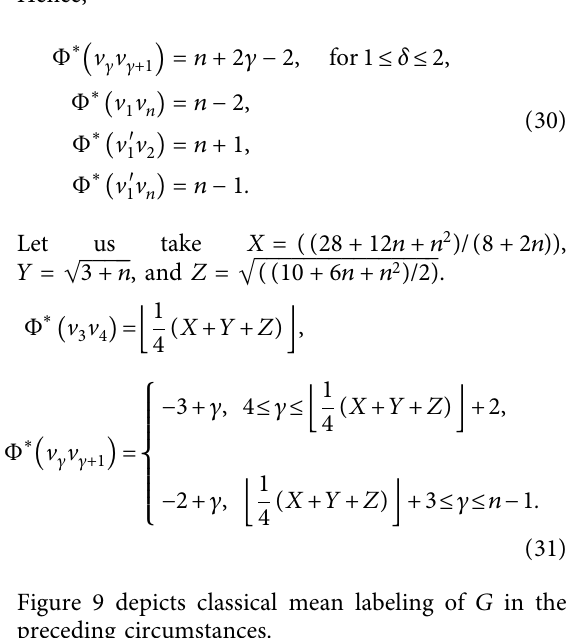
Table 31: Vertex labeling of Φ ( v ).